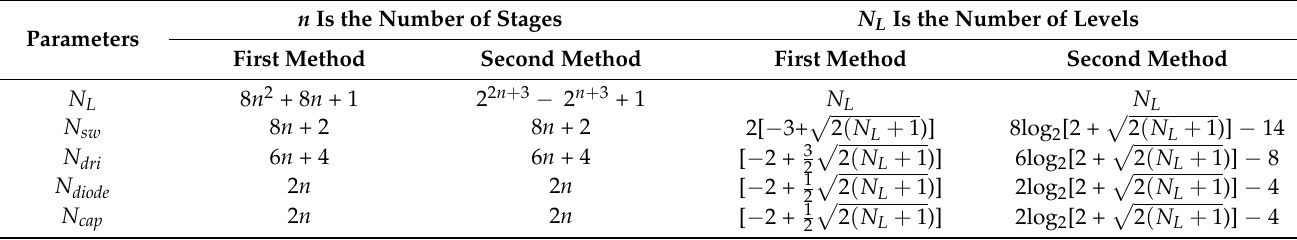
Table 1. Generalized formulas for different devices of